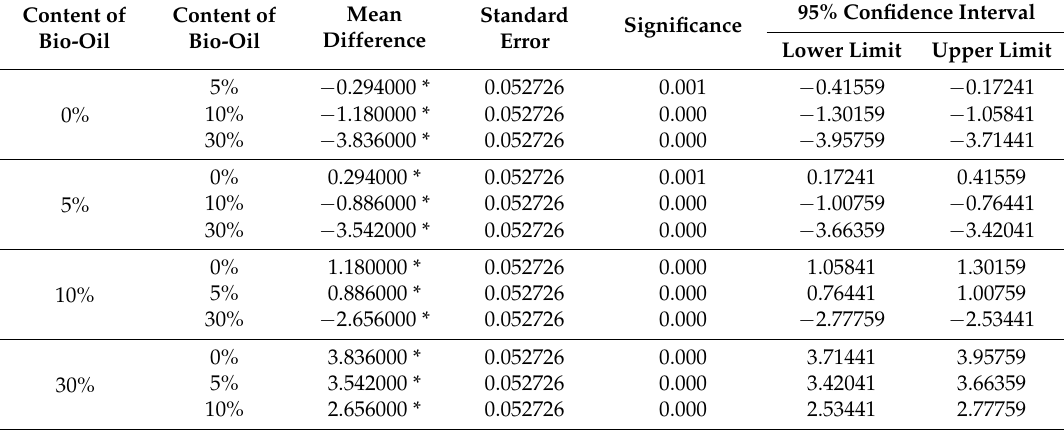
Note: * The significance level of the mean difference is 0.05.